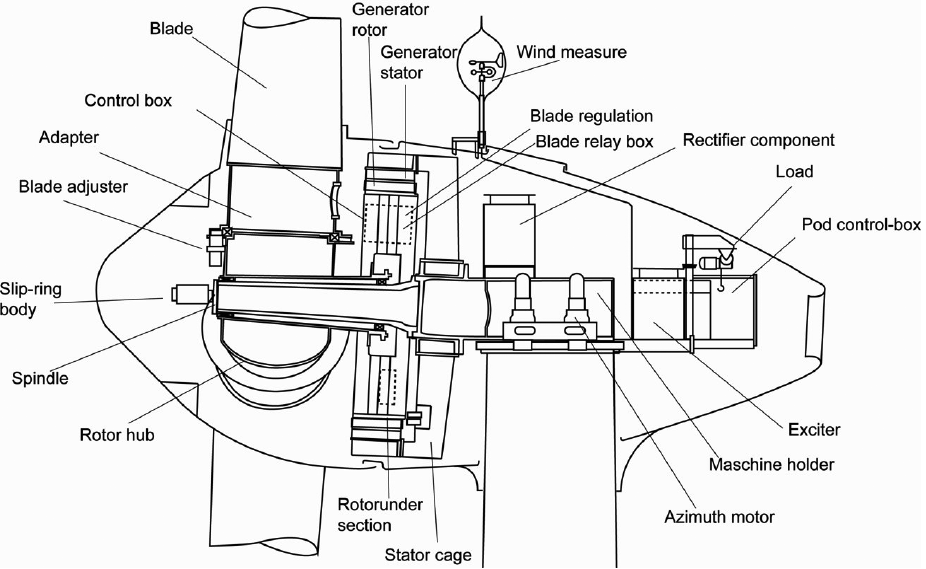
Fig. 4. – The design without gearbox (Enercon